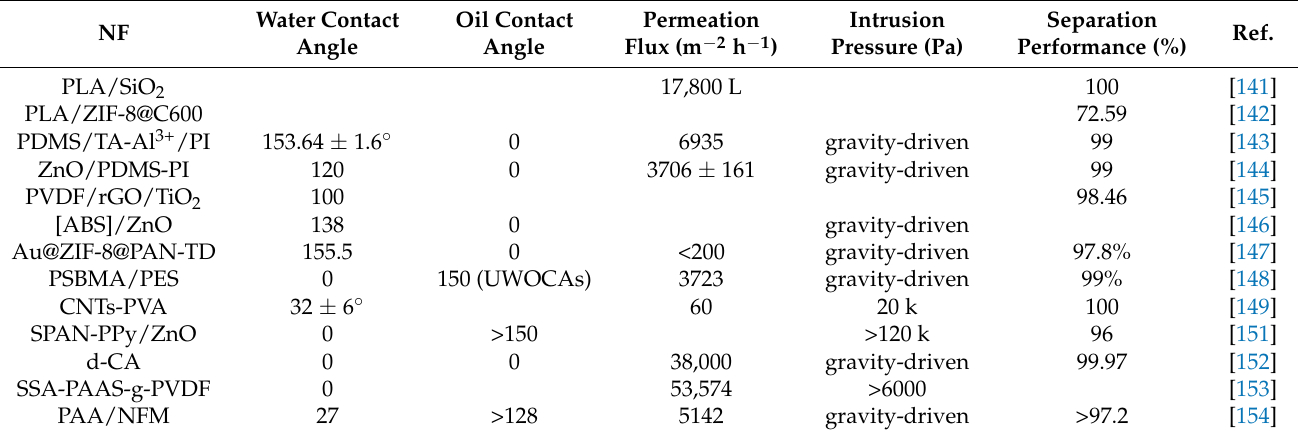
Table 3. Summary of optimum conditions for nanofibers used in oil/water